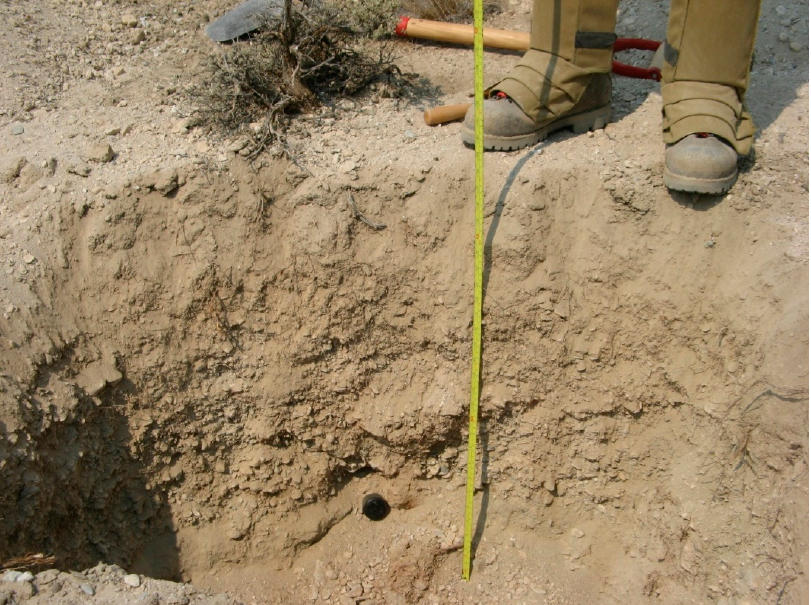
Figure 3. Photograph of the excavation into the 1720 m shoreline. The light ‐ shielded luminescence sample (metal tube with black cap) is visible in a sand ‐ rich layer near the bottom of the exposure.